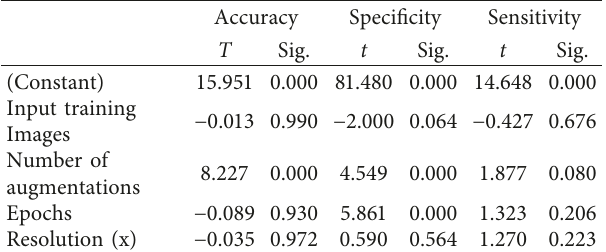
Figure 5: Accuracy of CNN with epochs shows maximum accuracy between 45 and 70 epochs. Table 2: t and p values of accuracy, specificity, and sensitivity.